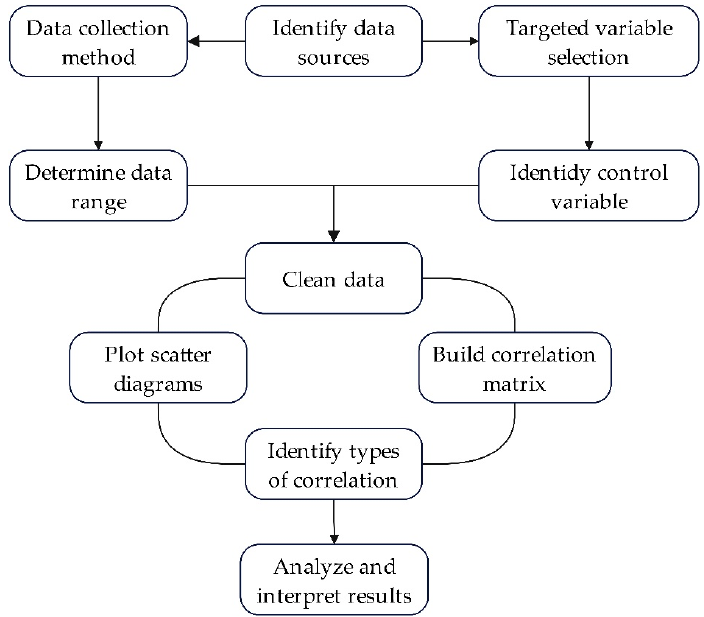
Figure 4. Conceptual research design.